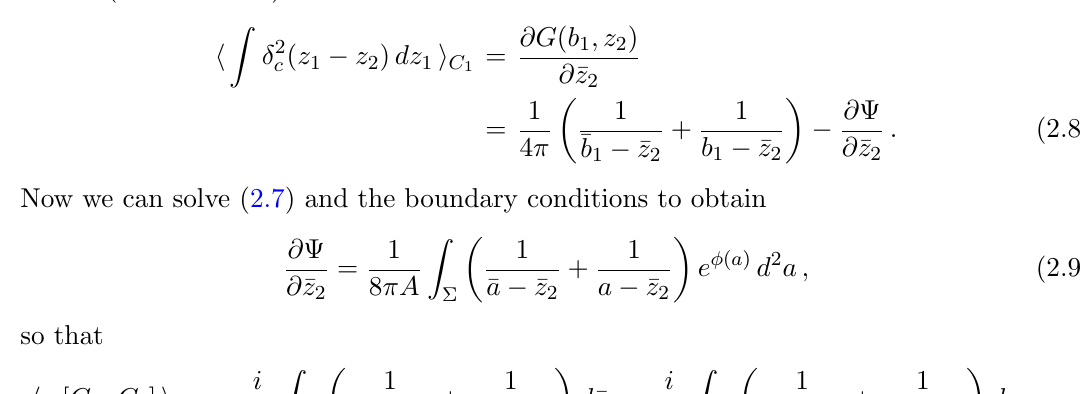
and so (for in(cid:12)nite T